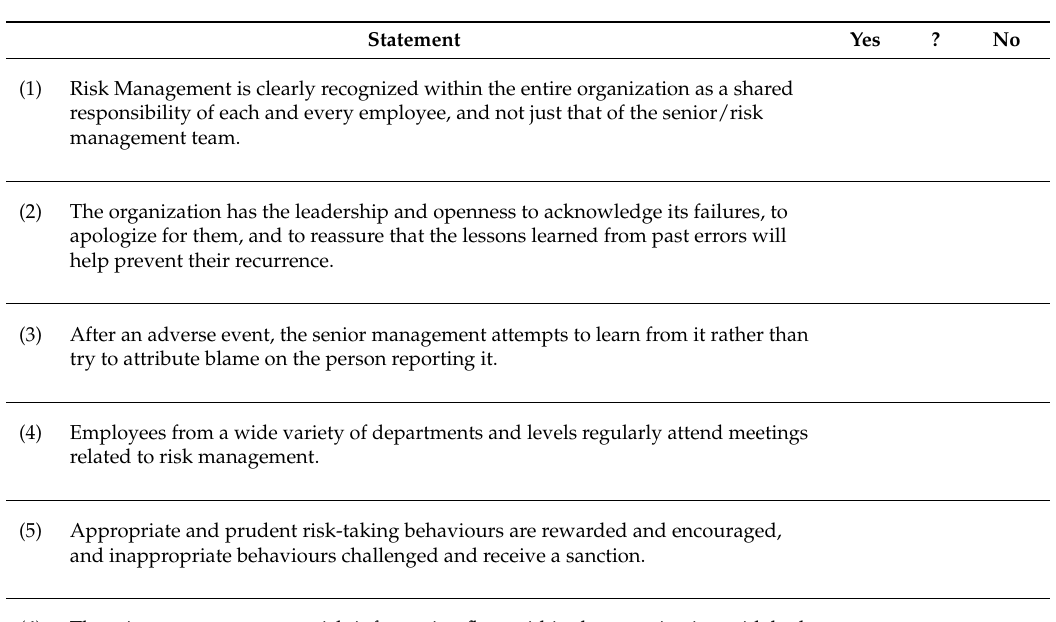
Table 3. Risk-Sentience Fertility (RSF)